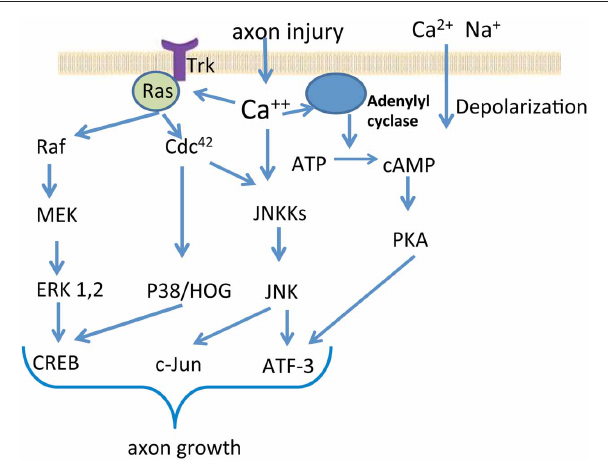
FIGURE 1 | Signal transduction in neuronal cells after nerve injury. The schematic diagram depicts several important signaling pathways activated by axon injury. Cellular injury induces sodium and calcium influx, which lead to depolarization. Among many other processes, the elevated intracellular calcium concentration leads to the activation of protein kinase pathways such as the MAPK Erk1 and Erk2, JNK, and P38 kinase. Downstream events influenced by axotomy-activated kinases include up-regulation or activation of several transcription factors. The modifications in the activity of transcription factors result in characteristic changes of gene expression in the injured and regenerating